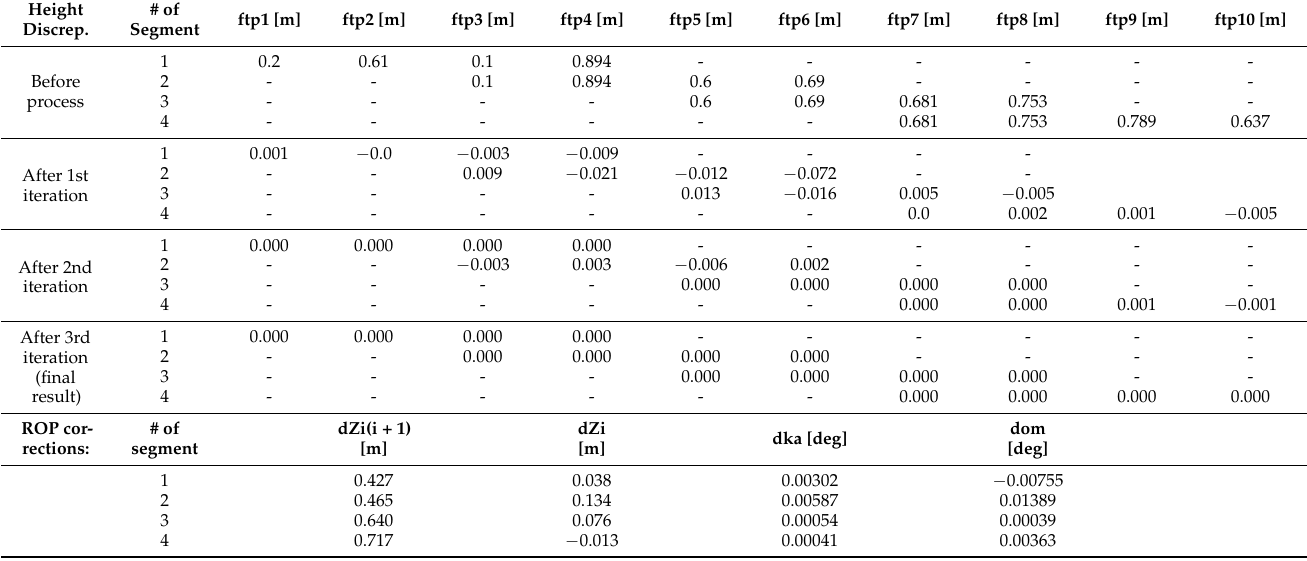
Table 2. Height discrepancies of four segments of real data before, during and after the process and final values of ROP corrections.